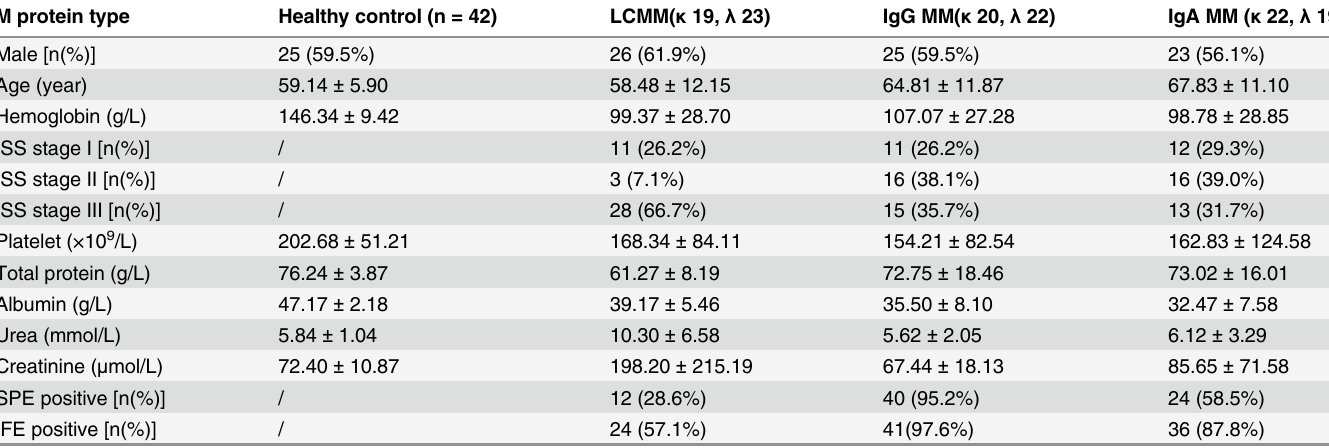
Table 1. The laboratory tests and basic clinical information in three MM groups and healthy control group. M protein